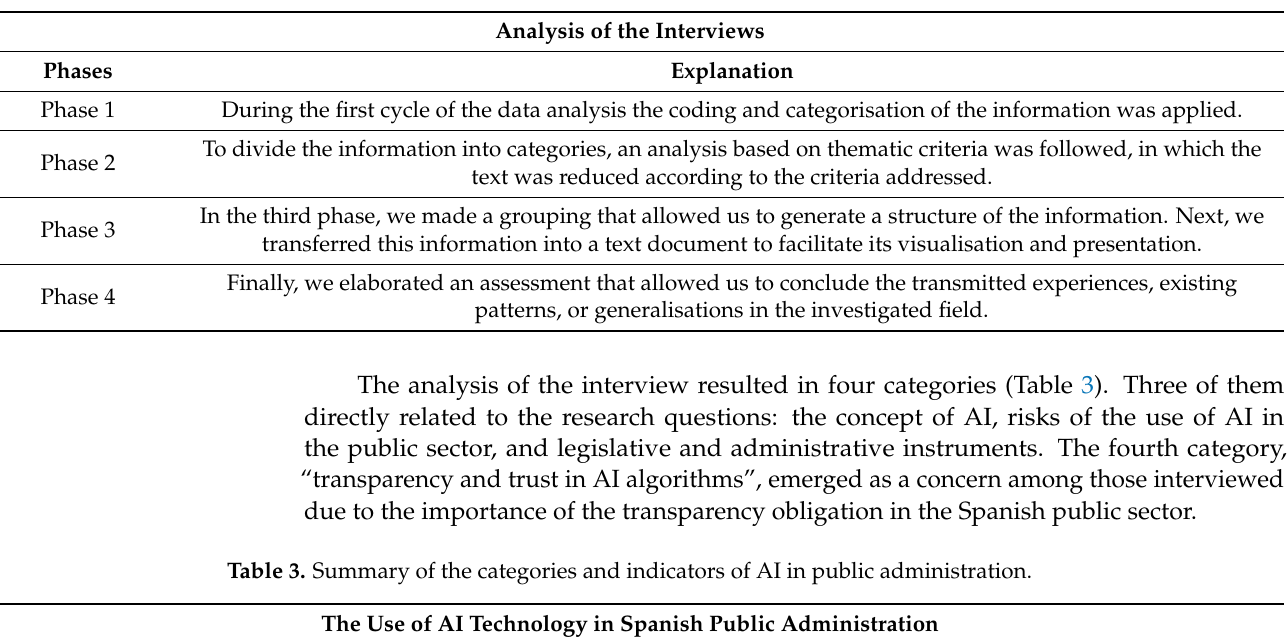
Table 2. Analysis of the interviews for stages.